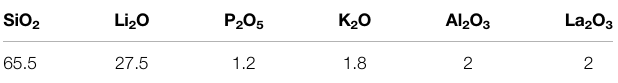
TABLE 1 | Composition of the base glass (Unit: